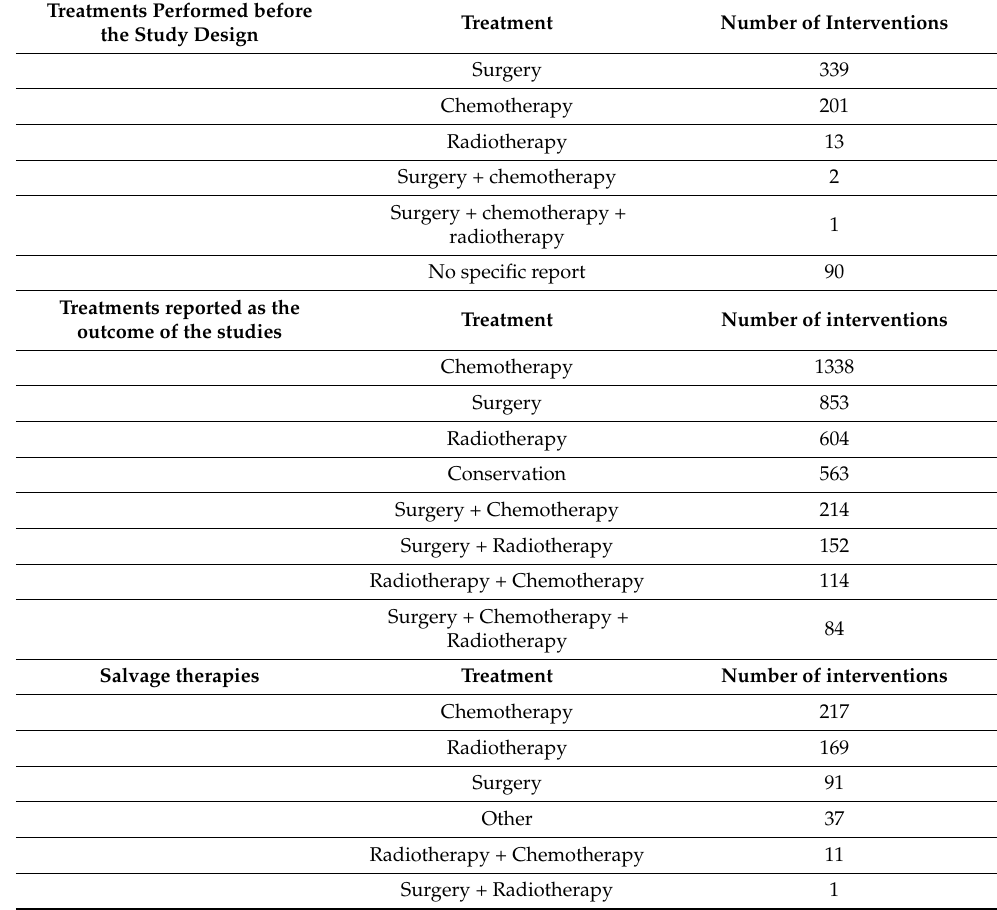
Table 3. The details of the treatment modalities of the OPG, according to the records of the patients. Treatments Performed before the Study Design